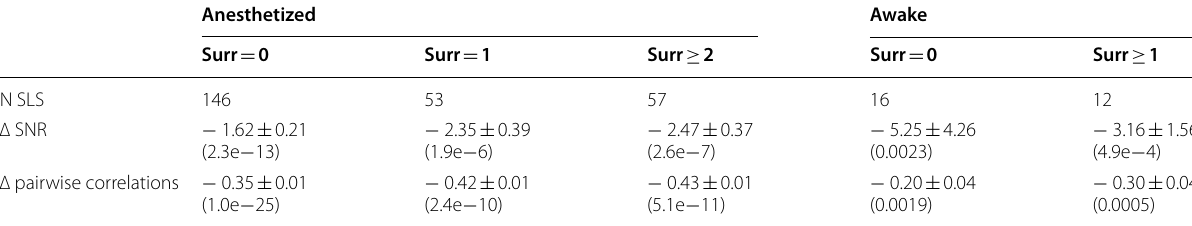
Only acquisitions with a reference raster segmentation are considered. Mean